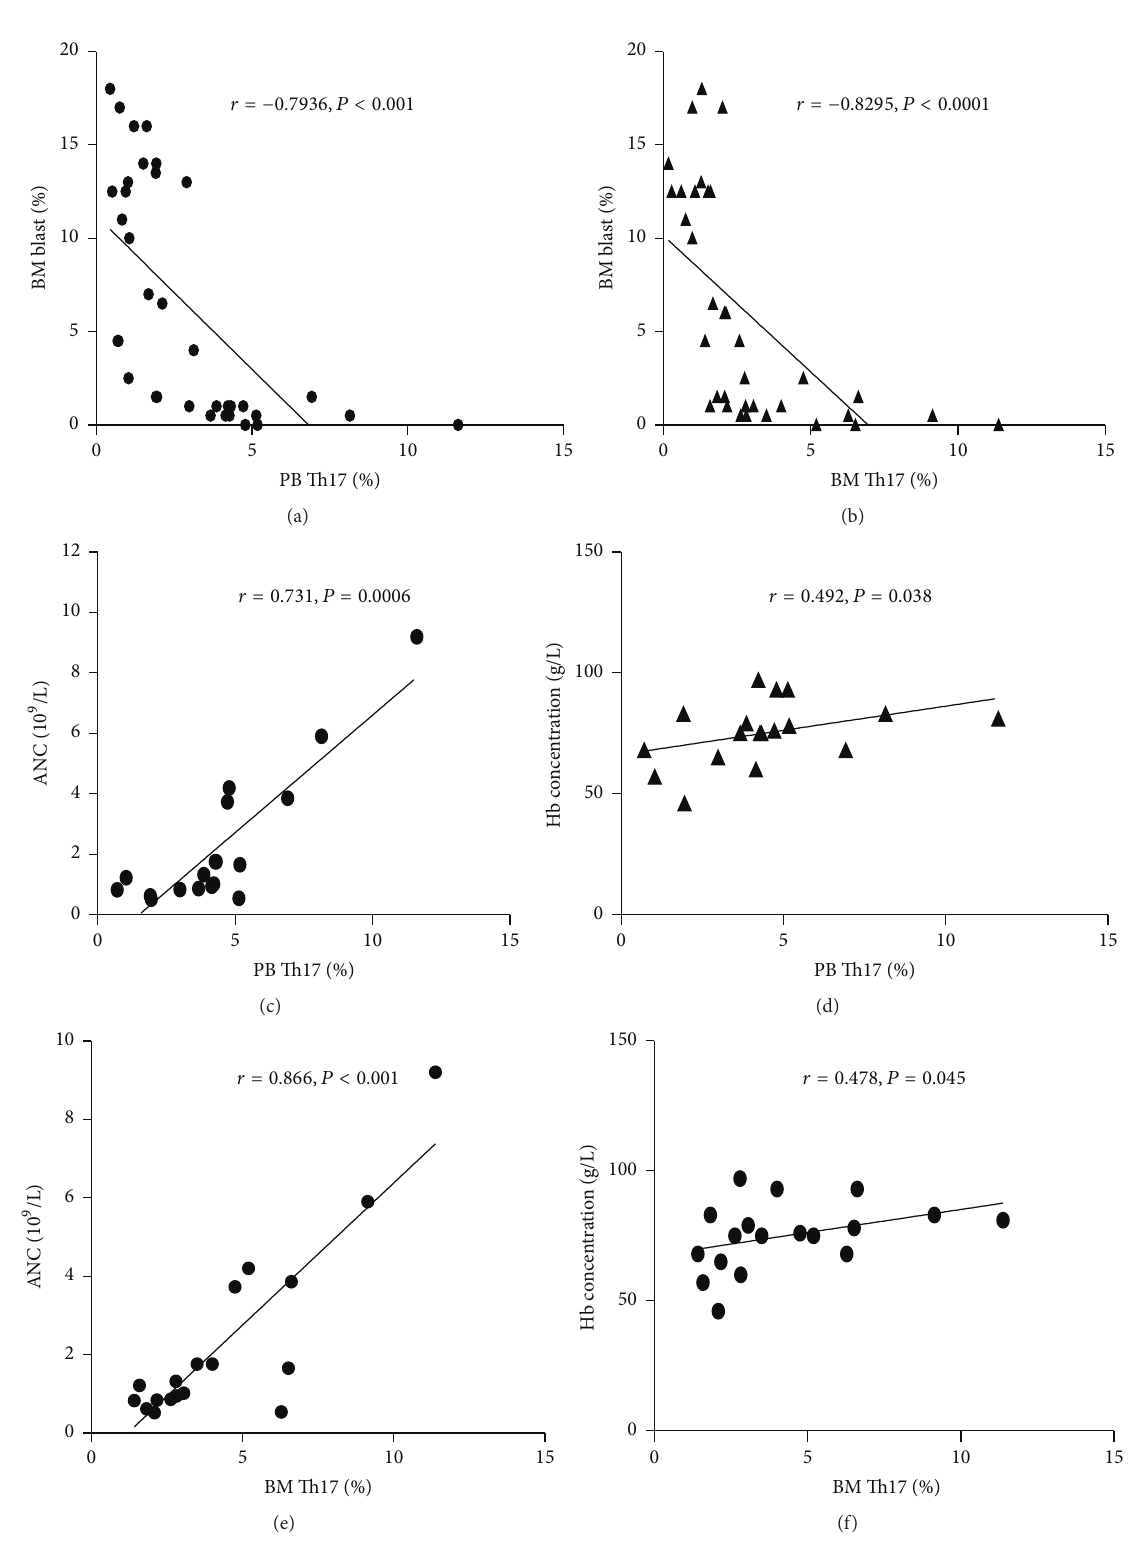
Figure 2: Th17 percentages negatively correlate with BM blast ratios and positively correlate with peripheral cell counts. Correlation analyses were performed between BM blast ratios and PB (a) or BM (b) Th17 percentages. Relationships between peripheral blood cell counts and PB (c-d) or BM (e-f) Th17 percentages were also